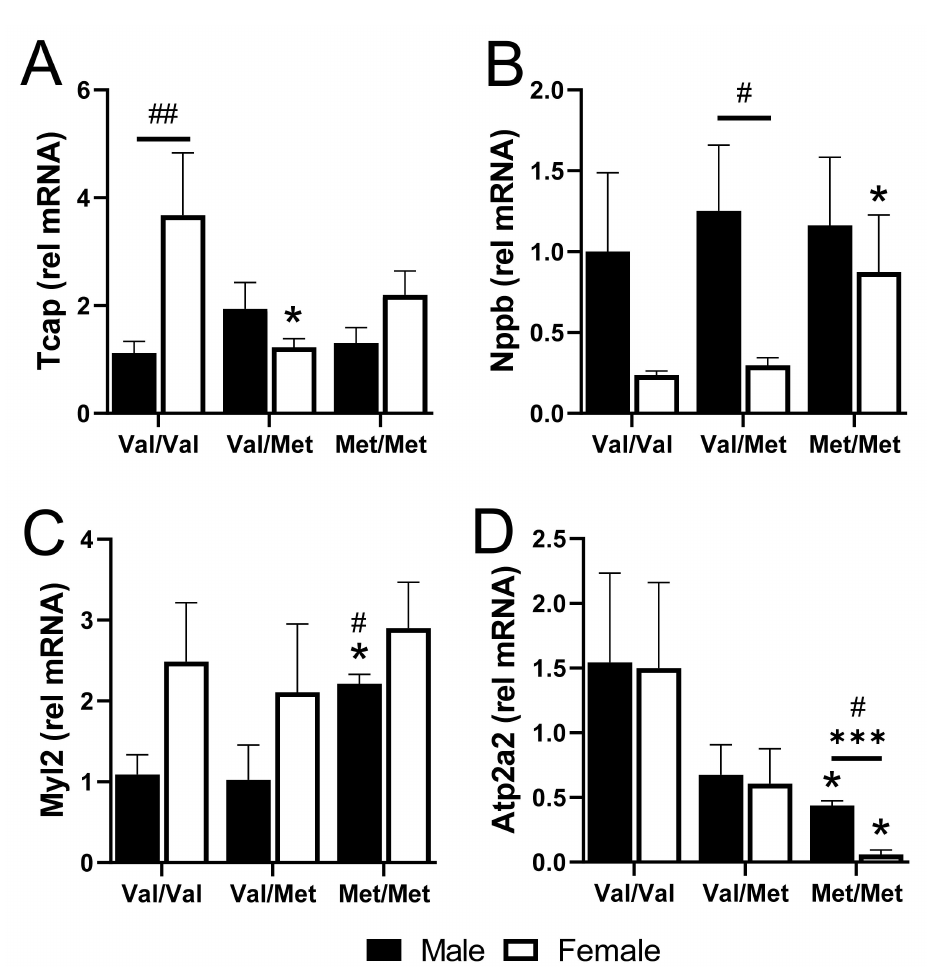
Figure 5. qPCR of select genes validates differences in whole hearts of males and females with and without the Met allele. Bar charts showing mRNA relative to GAPDH of titin-cap, Tcap ( A ), natriuretic peptide, Nppb ( B ), myosin light chain 2, Myl2 ( C ), and Atp2a2 ( D ) for males (black bars) and females (white bars) in each group. n = 3 or 4 each group, * p < 0.05 for pairwise comparisons between same-sex Val/Met or Met/Met versus respective Val/Val control mice. *** p = 0.0003 for pairwise comparison between male and female Met/Met mice. # p < 0.05 and ## p = 0.0007 using Mann–Whitney. Relative mRNA was calculated using the ∆∆ CT method with GAPDH as the internal normalization target and male Val/Val as the reference